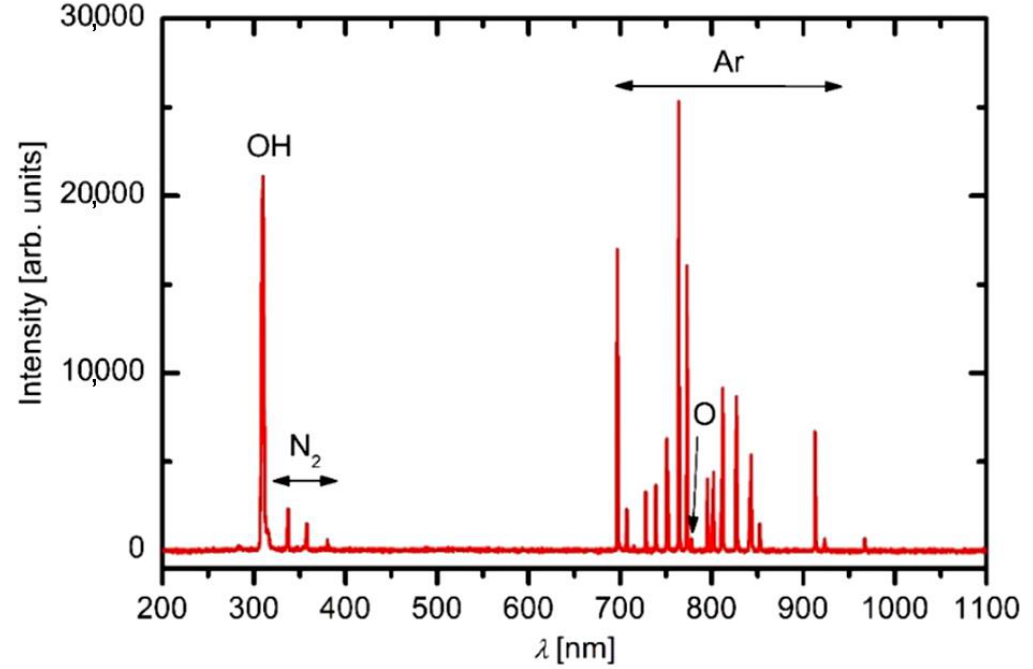
Figure 4. An optical spectrum acquired at a distance between the nozzle and the sample of 2 mm.